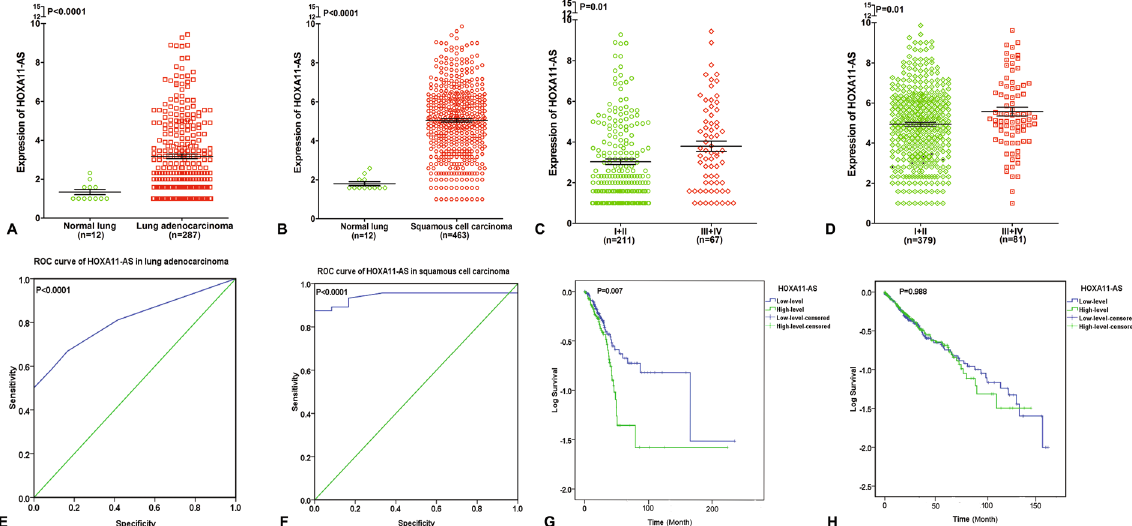
Figure 1. Differential expression and ROC curves of HOXA11-AS in lung adenocarcinoma and squamous cell carcinoma based on The Cancer Genome Atlas (TCGA) database. ( A ) Differential expression of HOXA11-AS in lung adenocarcinoma. ( B ) Differential expression of HOXA11-AS in squamous cell carcinoma. ( C ) Differential expression of HOXA11-AS in stage (I + II) and stage (III + IV) in lung adenocarcinoma. ( D ) Differential expression of HOXA11-AS in stage (I + II) and stage (III + IV) in lung squamous cell carcinoma. ( E ) ROC curve of HOXA11-AS in lung adenocarcinoma. ( F ) ROC curve of HOXA11-AS in lung squamous cell carcinoma. ( G ) Kaplan-Meier curves of HOXA11-AS expression in lung adenocarcinoma. ( H ) Kaplan-Meier curves of HOXA11-AS expression in lung squamous cell carcinoma.